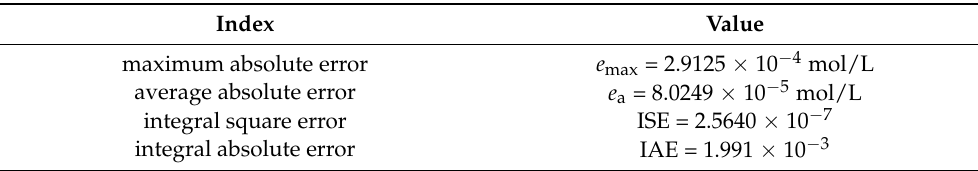
Table 2. Quantitative assessment of the accuracy of the identified constant temperature model (deviation between simulated and measured response).